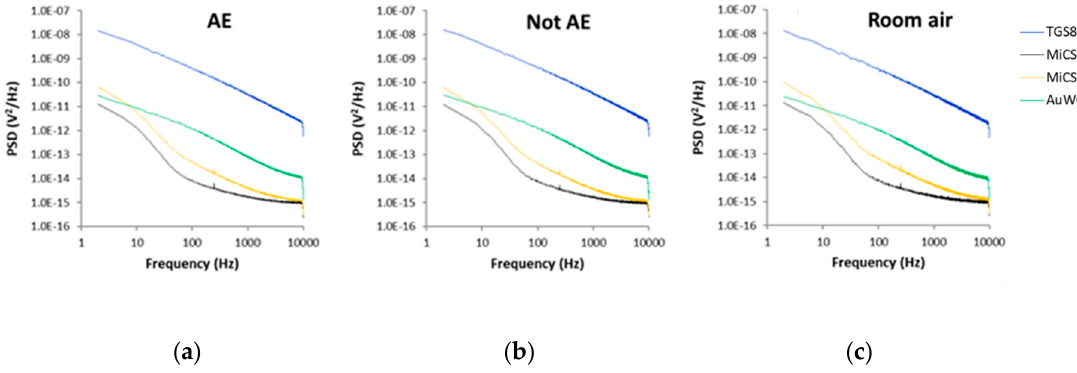
Figure 6. Average power spectral densities (PSD) value of sensors fluctuations recorded in the presence of: ( a ) Breath samples of all AE patients; ( b ) Breath samples of all control volunteers; ( c ) All room air samples. AE: Alveolar echinococcosis; Not AE: Control.